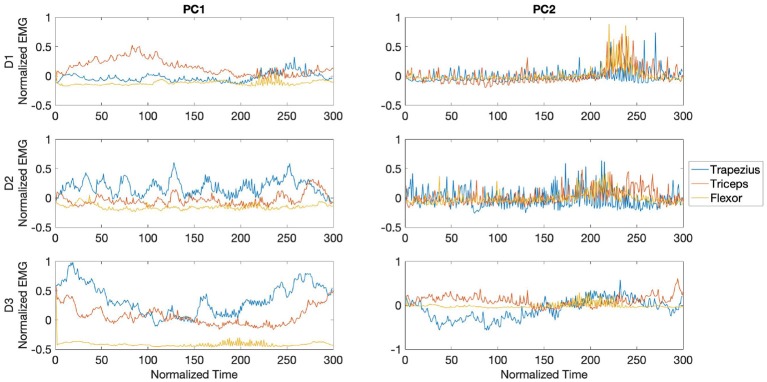
Waveforms showing the two principal components of muscle activation across the trapezius (blue), triceps (orange), and wrist flexor (yellow) muscles for drummers D1-3 in the slow phase (bottom right panel in Figure 7). Each panel shows the activation pattern centered around stroke onset (150 ms).